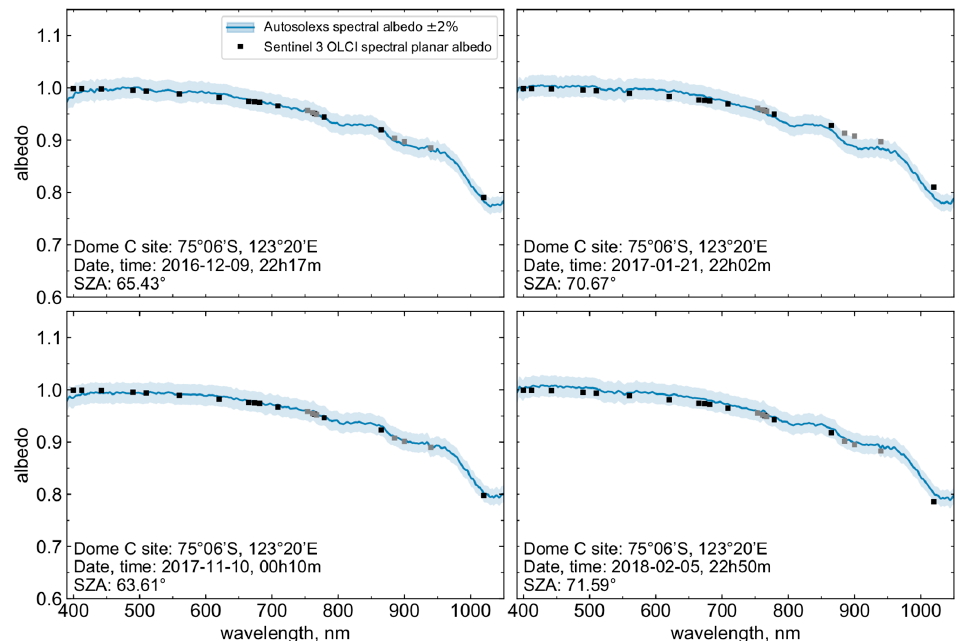
Figure 9. Intercomparison of the retrieved spectral planar albedo from Sentinel-3 OLCI using the Snow Properties Processor (SPP) (black squares) and Autosolexs albedo (blue lines) measured at Dome C, Antarctica for four different dates across the 2016–2017 and 2017–2018 summer seasons. The shaded area around the measurements represents the optimum uncertainty target of ±2%. The absorption bands of oxygen and water vapor are marked here as grey squares.